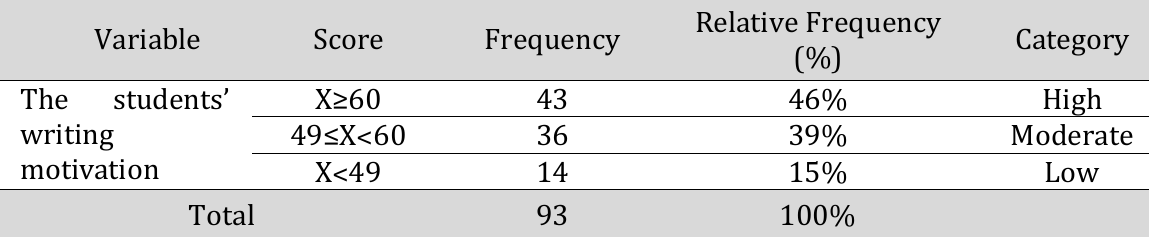
Table 13. categorization of the students’ writing